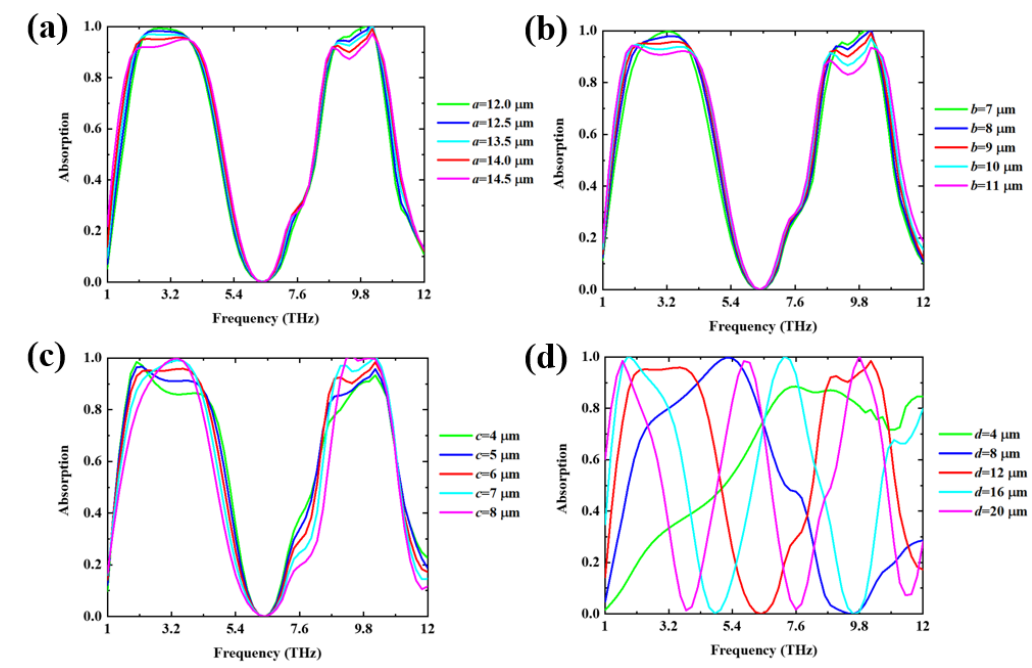
Figure 6. When σ is 2 × 10 5 S / m, the absorption spectrum changes with the major axis of the ellipse ( a ), the minor axis of the ellipse ( b ), the radius of the inner circle ( c ) and the thickness of SiO 2 ( d ).